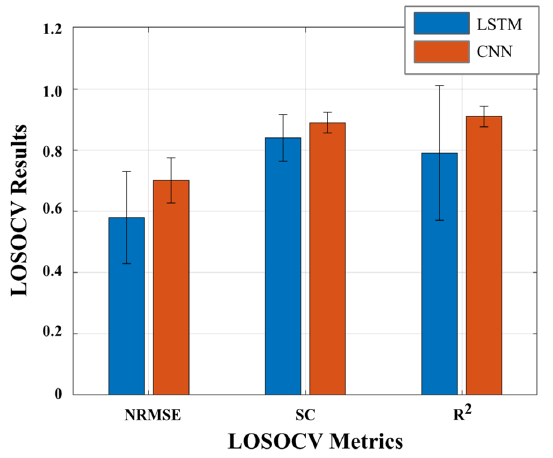
Figure 3. LOSOCV results for both DL regression models without using EMG signals.